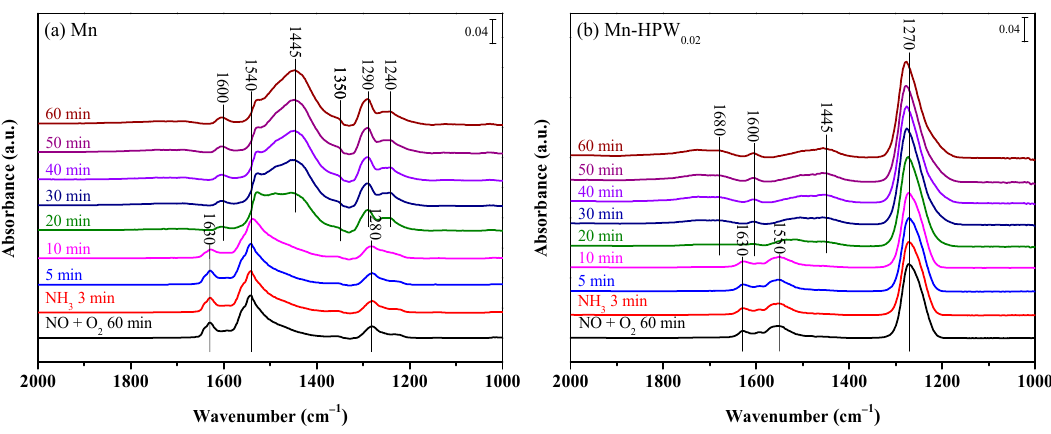
Figure 13. DRIFT spectra obtained by subtracting the corresponding background spectra of of NH 3 reacted with pre-adsorbed NO x -derived species at 120 °C on Mn ( a ) and Mn-HPW 0.02 ( b ).